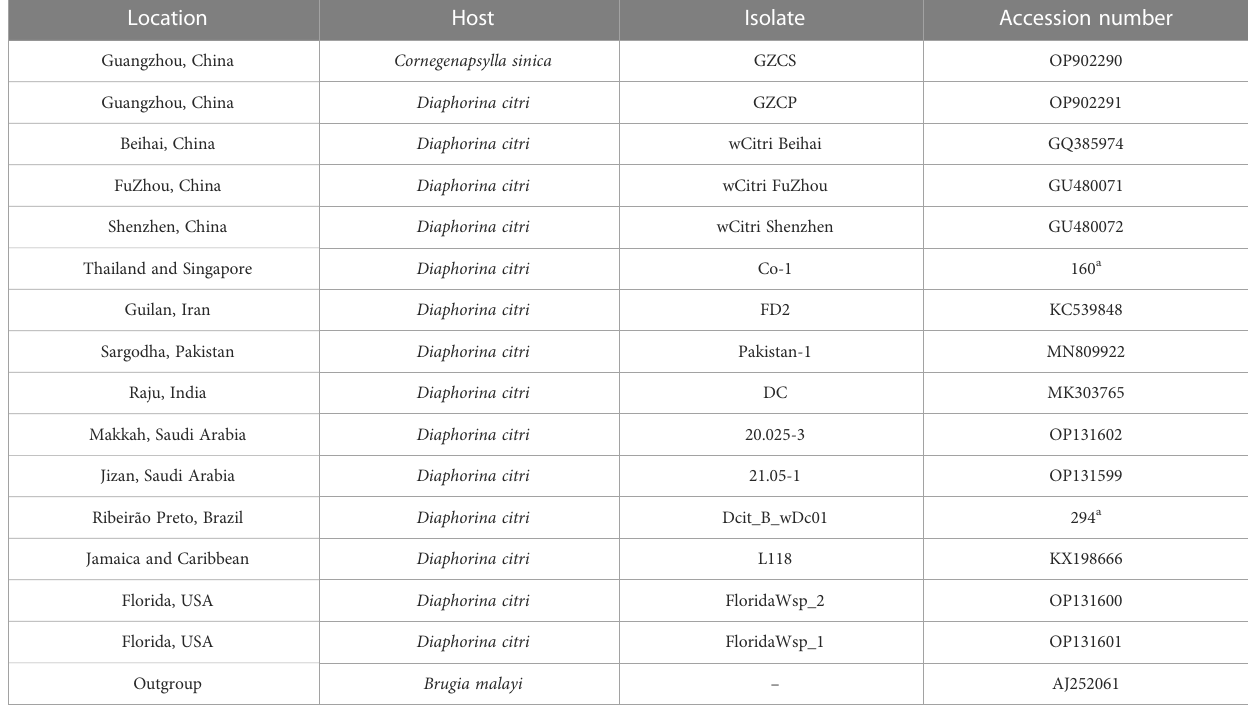
TABLE 4 Accession numbers for wsp gene sequences obtained from GenBank and the Wolbachia